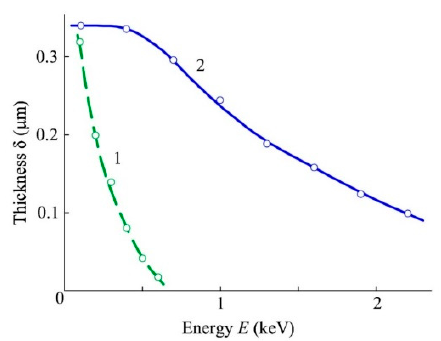
Figure 8. Dependence of the films thickness δ on the energy E of bombarding fast atoms. 1—the deposition time τ = 120 min, the argon pressure p = 0.4 Pa, the voltage between the hollow cathode and the target U t = 0, the discharge current in the anode circuit I d = 1.8 A. 2— τ = 20 min, p = 0.4 Pa, U t = 2 kV, I d = 1.8 A.